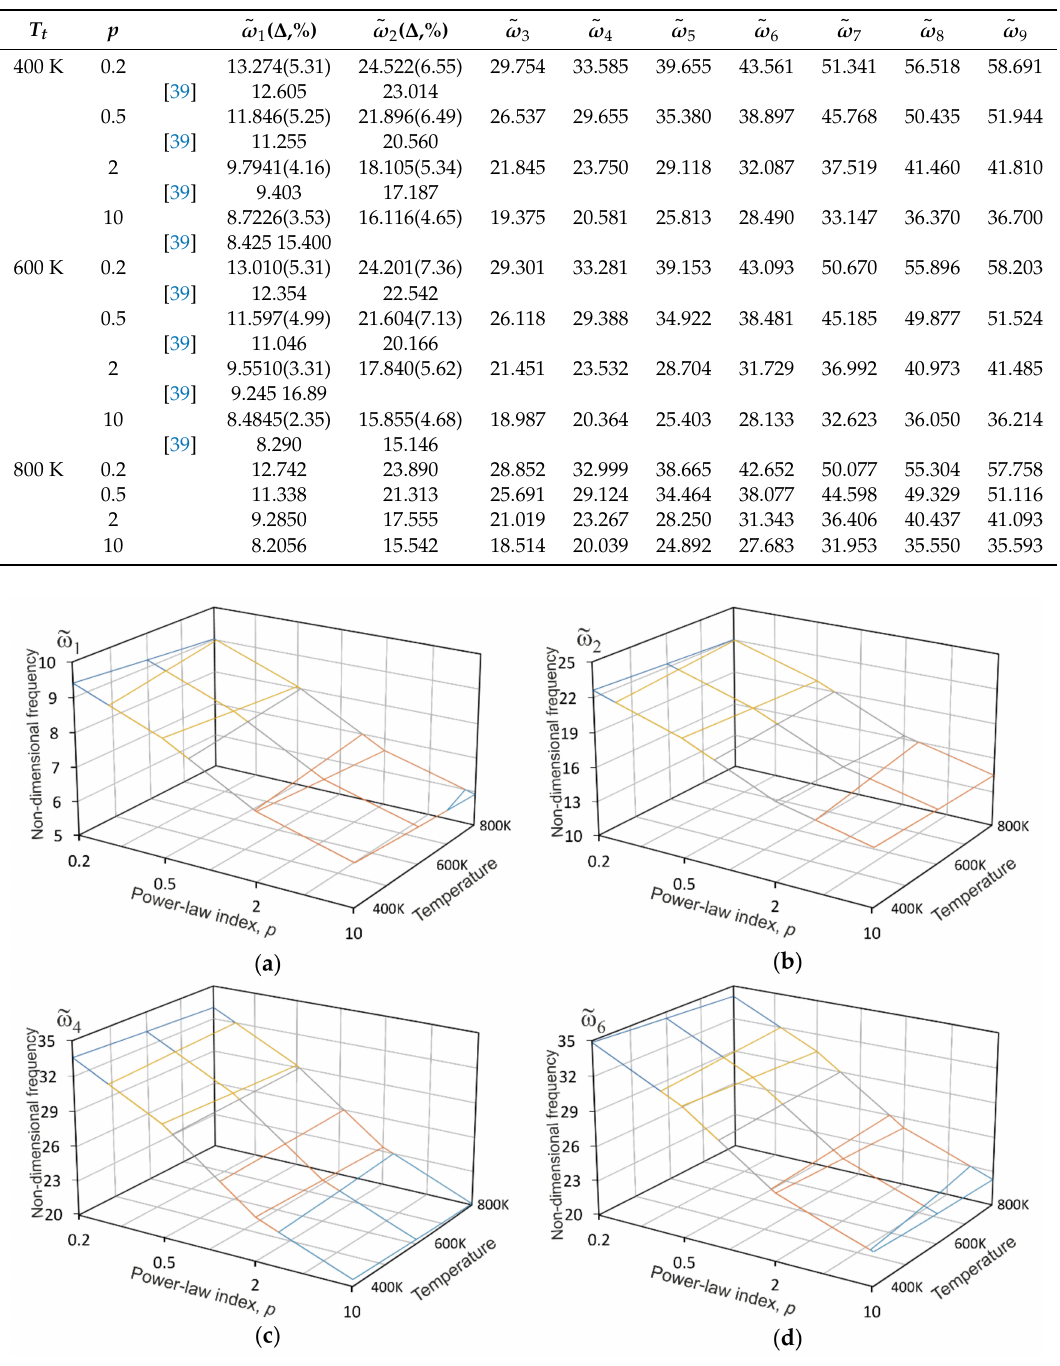
Figure 7. The e ff ect of the temperature on natural frequencies of SSSS square 1-8-1 sandwich plates with di ff erent material gradients in SUS304 / Si 3 Ni 4 cores: ( a ) the first nondimensional frequency; ( b ) the second non-dimensional frequency; ( c ) the fourth non-dimensional frequency; and ( d ) the sixth non-dimensional